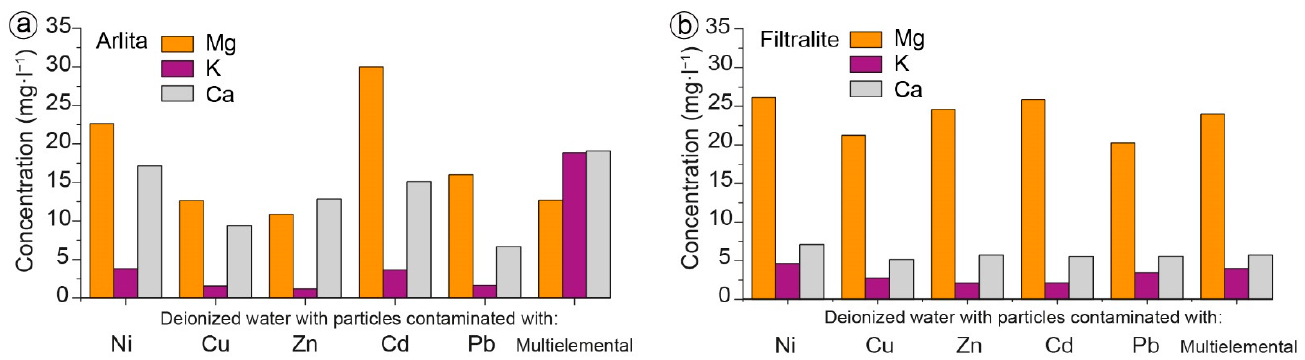
Figure 6. Final concentration equilibrium (Ce) for Mg, K, and Ca in the batch tests with deionized water and 5 g of contaminated particles from previous batch tests with contaminated solutions (individual and multiple contaminants) employing Arlita ( a ) and Filtralite ( b ).